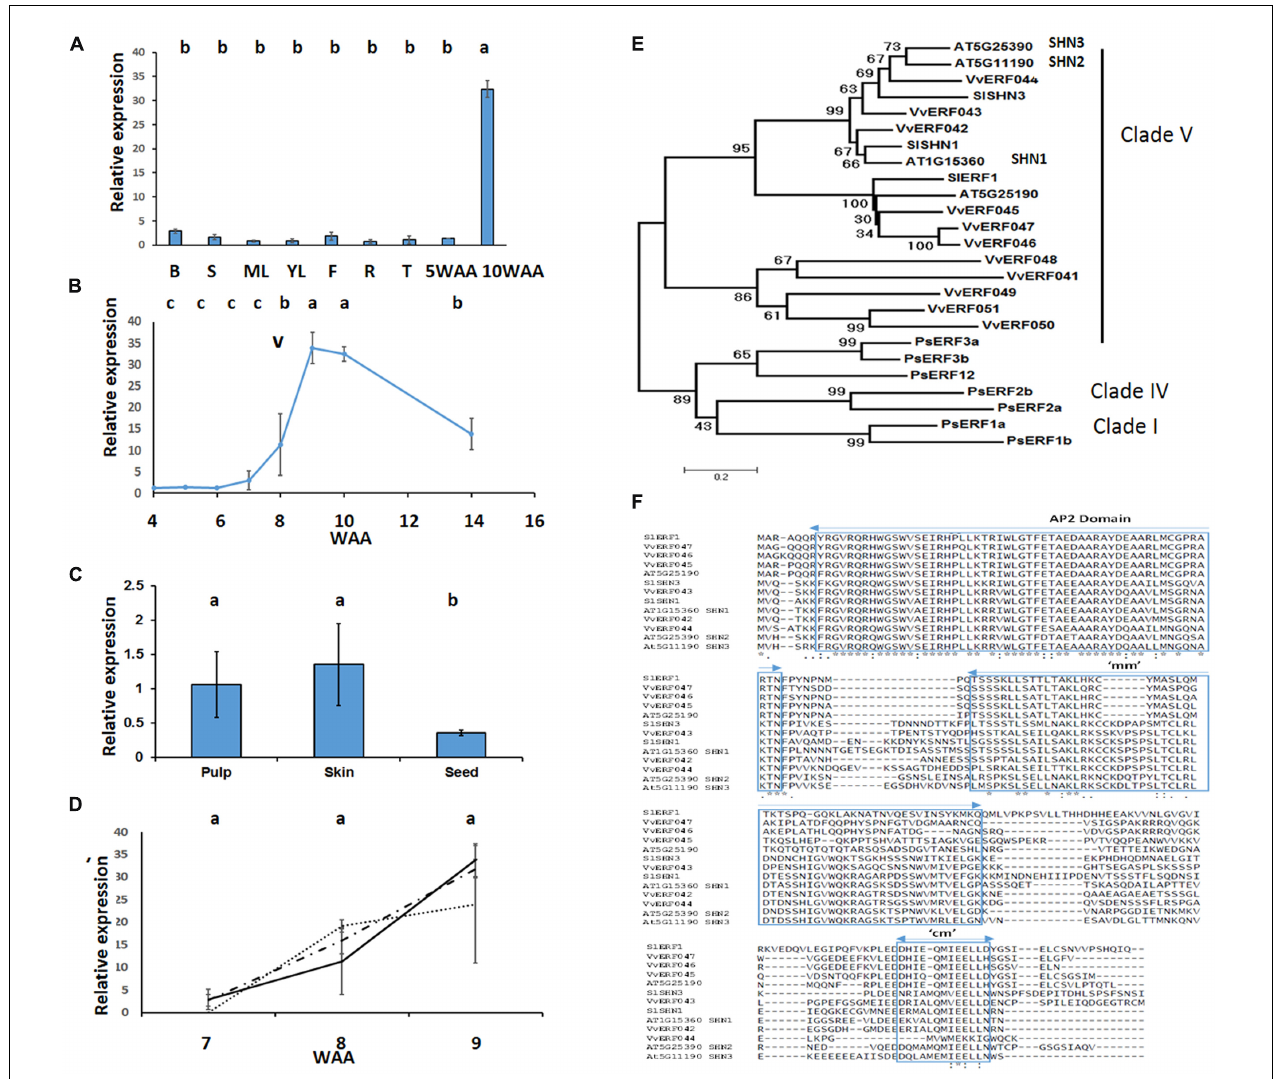
FIGURE 1 | VviERF045 expression pattern and protein sequence comparative analysis. Left panel: real time RT-qPCR analysis of VviERF045 expression profile in different tissues (A) : B, Bud; S, Shoot; ML, Mature Leaf; YL, Young Leaf; F, Flower; R, Root; T, Tendril; 5WAA, berry at 5 weeks after anthesis (WAA); 10 WAA, berry at 10 WAA. ML and YL were used as reference samples. (B) VviERF045 expression in different fruit parts: pulp, skin and seed at 10 WAA. Pulp is taken as calibrator (C) VviERF045 expression at different developmental stages, berry developmental stages are indicated as WAA, (v) indicates véraison. (D) VviERF045 expression after 1-MCP and ethephon treatment: points represent 1-MCP treatment, points and lines represent ethephon treatment and continuous line represents control. Error bars represent SD and are based on three biological and two technical replicates. Data were normalized using ubiquitin and tubulin as reference genes. Different letters in the figure mean significant difference ( p < 0.05) according to Tuckey’s post hoc test. Right panel: (E) Phylogenetic tree of the ERF amino acid sequences from Prunus salicina [PsERF1a (FJ026009), PsERF1b (FJ026008), PsERF12 (FJ026003), PsERF3a (FJ026005), PsERF3b (FJ026004), PsERF2a (FJ026007), PsERF2b (FJ026006)], Arabidopsis thaliana [AT5G25190 (NP_197901.1), AT1G15360-SHN1 (NP_172988.1), AT5G25390-SHN3 (NP_197921.1), AT5G11190-SHN2 (NP_196680.1)], Solanum lycopersicum [SlSHN1 (XP_004235965.1), SlSHN3 (XP_004240977.1), SlERF1 (NP_001234848.1)] and Vitis vinifera ERF from clade V [VviERF045, VviERF042, VviERF051, VviERF044, VviERF043, VviERF048, VviERF049, VviERF041, VviERF050, VviERF047, VviERF046]. The aa sequences were selected based on these criteria: (i) Grapevine ERFs belonging to the same clade of VviERF045, (ii) Prunus salicina ERF sequences related to fruit ripening, (iii) Best blastx matches to VviERF045 from A. thaliana and S. lycopersicum . Numbers on the branch represent the percentage for bootstrap value n = 1000. (F) Alignment of the amino acid sequences of clade V of the phylogenetic tree. ‘AP2,’‘mm’ and ‘cm’ conserved domains are represented as blue